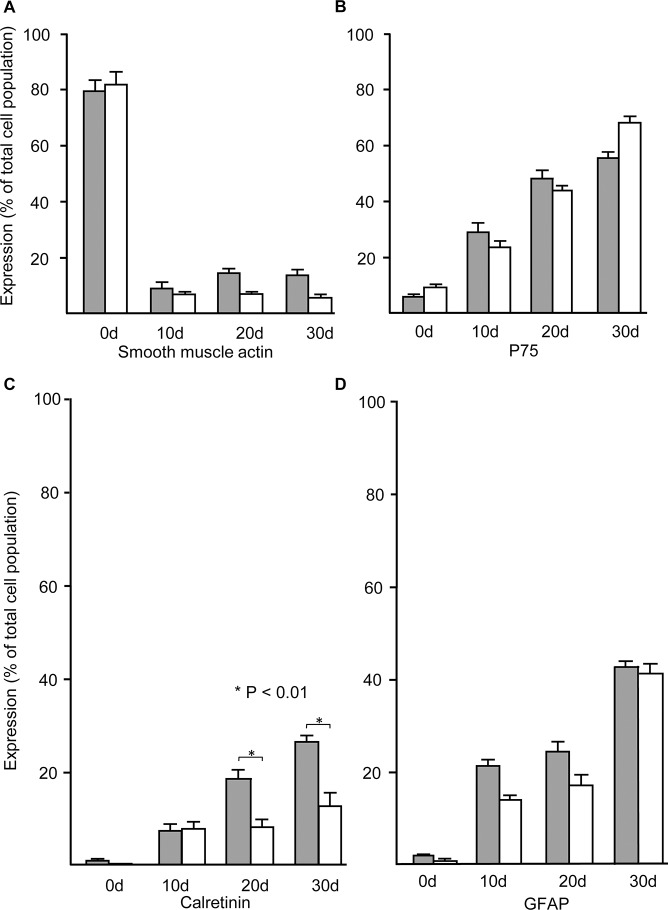
Time course of expression of cell-specific markers by cells immediately after dissociation from ganglionic and aganglionic Hirschsprung gut, and during neurosphere culture.Shaded columns show the percentage of cells in the populations derived from ganglionic Hirschsprung gut, and open columns the percentage from aganglionic Hirschsprung gut. The proportion of cells expressing smooth muscle actin (SMA) drops significantly immediately after isolation (0d) and remains low in the populations of cells dissociated from both ganglionic and aganglionic neurospheres (A). In contrast, expression of the neural crest marker p75 is low in initial isolates (0d) but increases over time until the majority of both ganglionic and aganglionic cells are p75 positive by 30 days (B). The percentage of cells expressing the ENS marker calretinin in isolates from ganglionic gut was very low (<2%) and undetectable in aganglionic isolates (C). However, after 1 day culture the proportion of calretinin positive cells increased in both ganglionic and aganglionic neurospheres, although after 20 days it remained significantly lower in the aganglionic neurospheres compared with ganglionic neurospheres (P<0.01). Low numbers of cells expressing GFAP were present in initial isolates of ganglionic and aganglionic gut, but their numbers increased gradually over the 30 day period of neurosphere culture (D). Error bars show SEM, n = 5 for both ganglionic and aganglionic cultures.